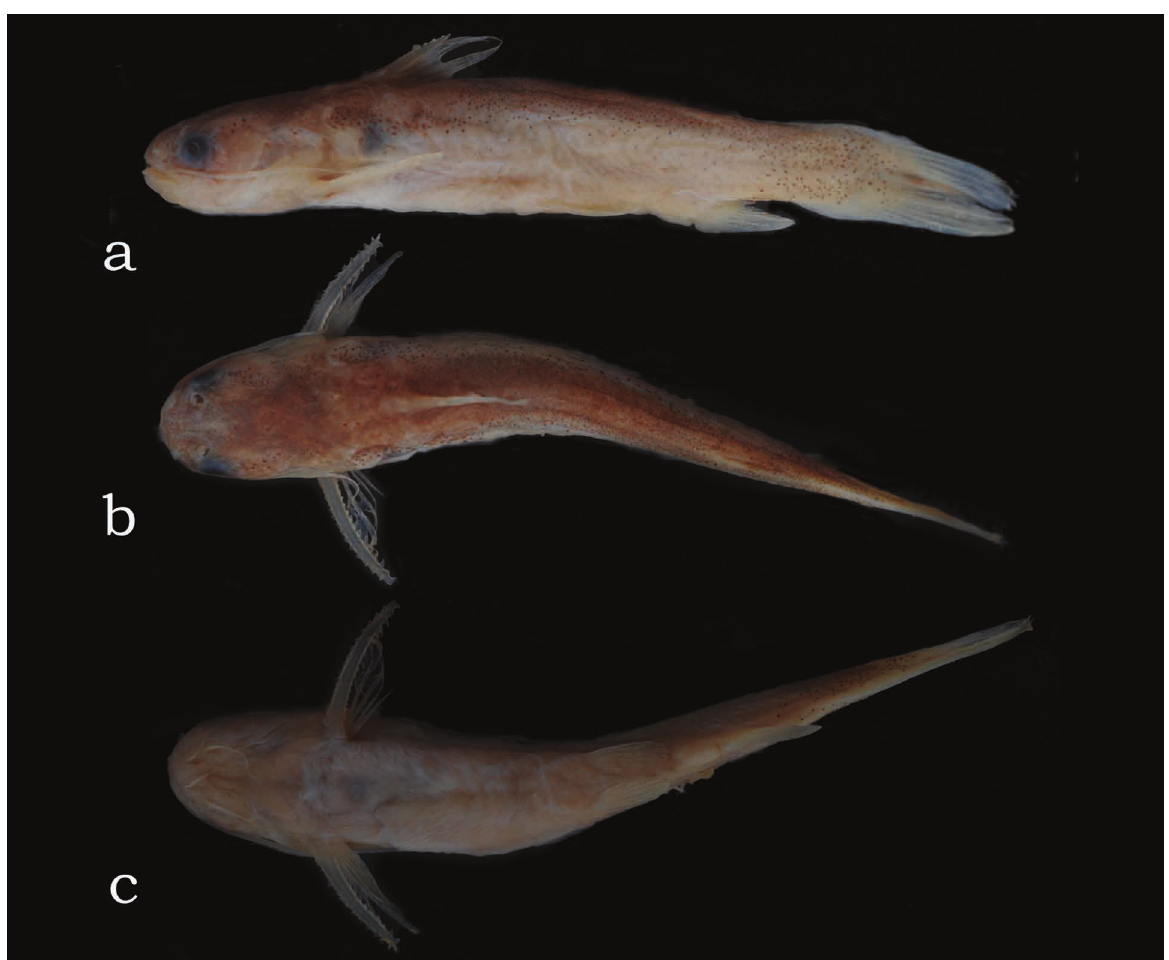
Fig. 1. Centromochlus britskii , new species, holotype, MZUSP 115271, male, 39.2 mm SL, UHE Ilha Solteira, upper rio Paraná basin, Ilha Solteira, São Paulo State, Brazil. Lateral (a), dorsal (b) and ventral (c)